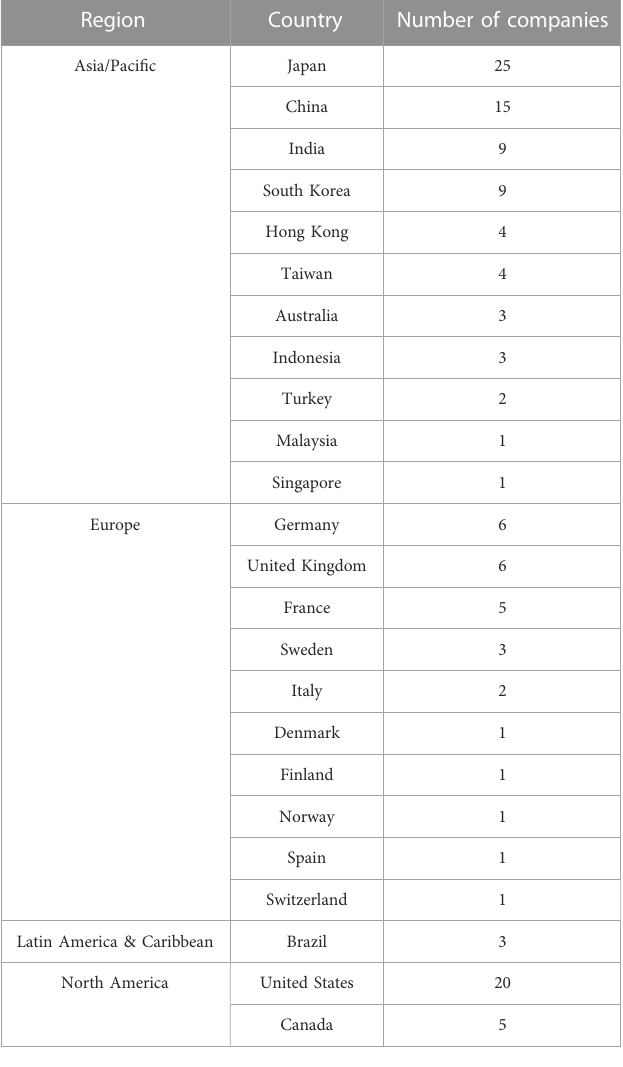
TABLE 1 Number of companies analyzed by region and